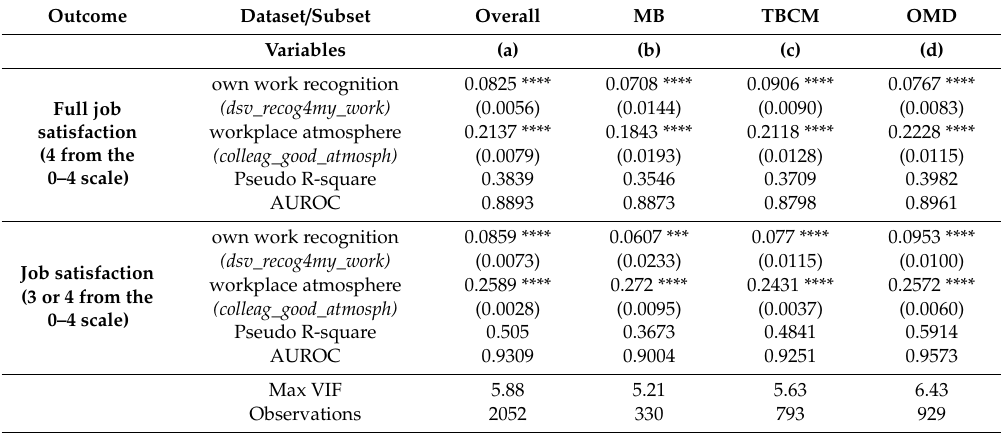
Table 2. The second round of robustness checks (residence) for both components of the core, as average marginal e ff ects on job satisfaction based on binary logistic regressions for both forms of the